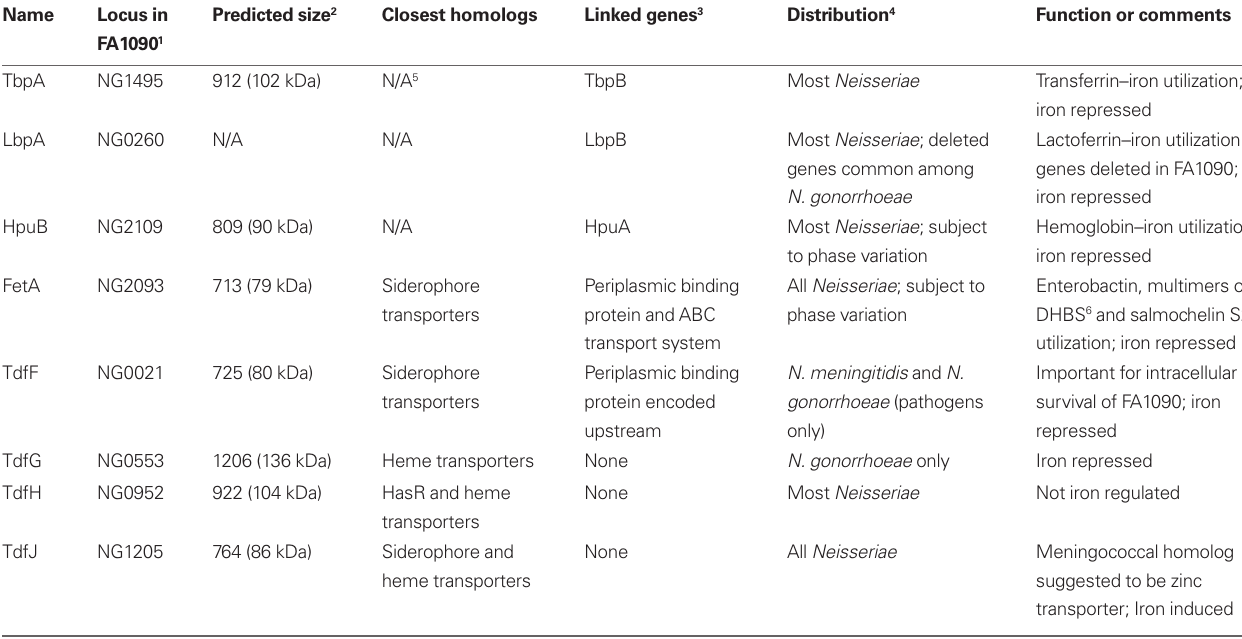
Table 1 | TonB-dependent transporters encoded in the gonococcal genome.